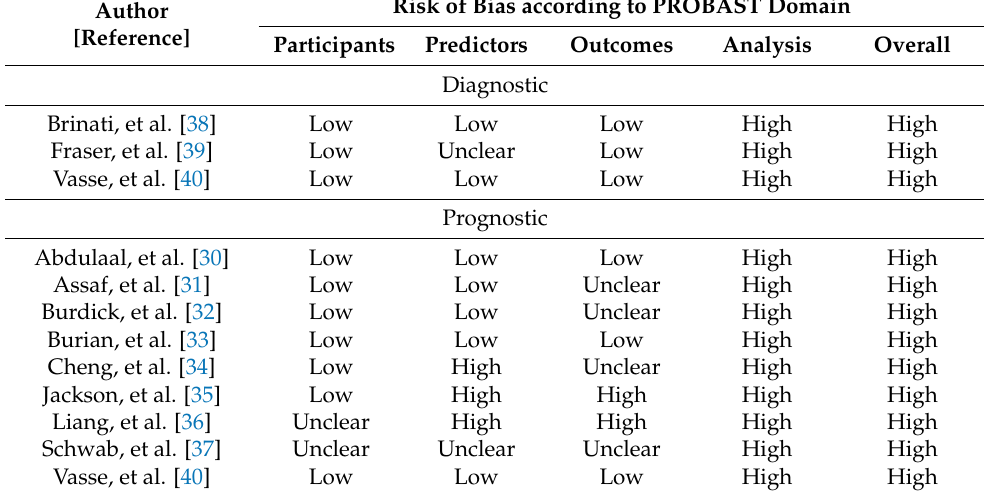
Table 2. PROBAST (prediction model risk of bias assessment tool) assessment of predictive mod- elling